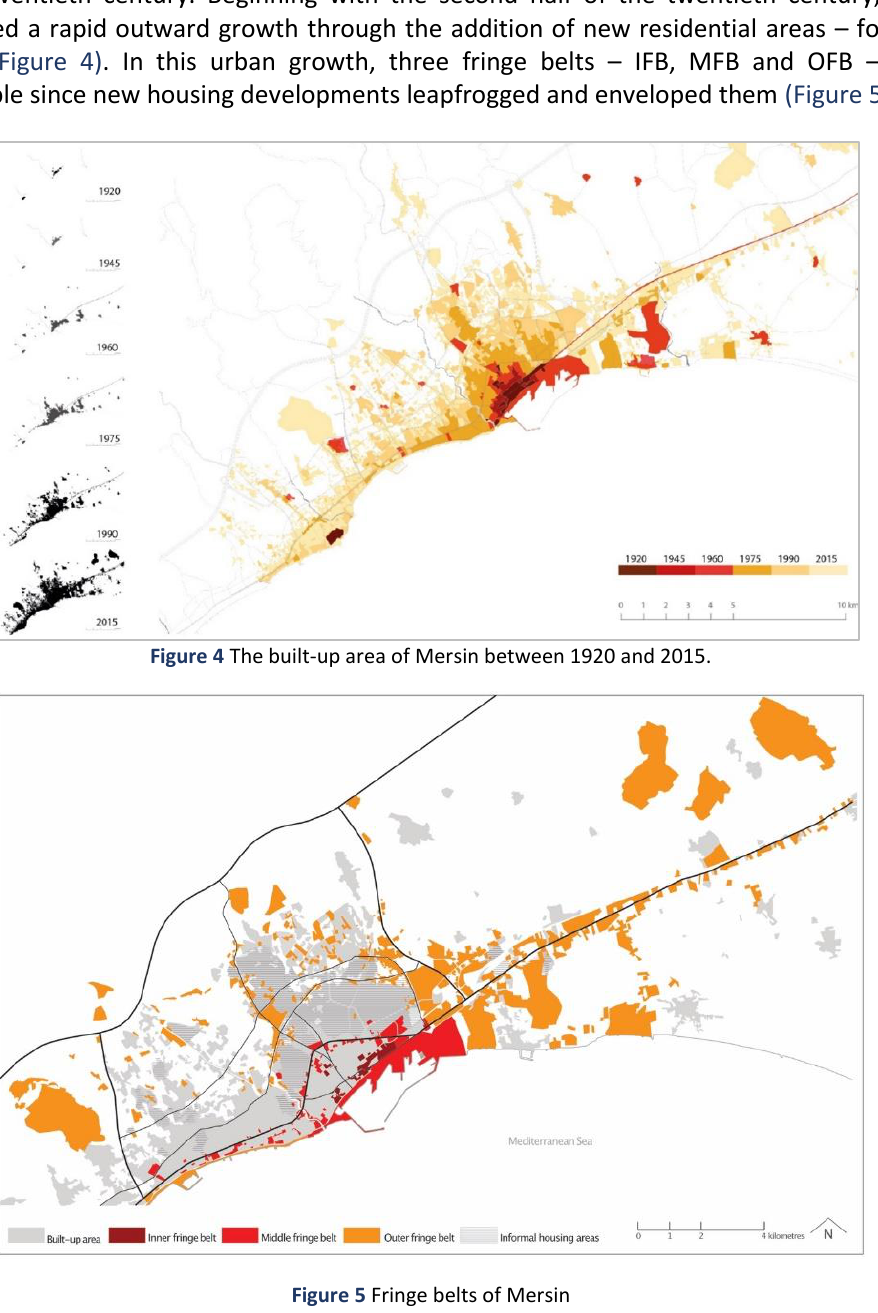
Figure 5 Fringe belts of